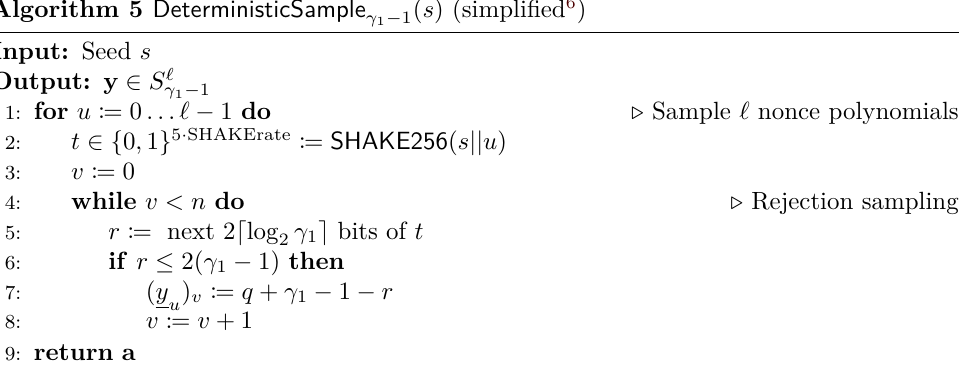
Algorithm 5 DeterministicSample